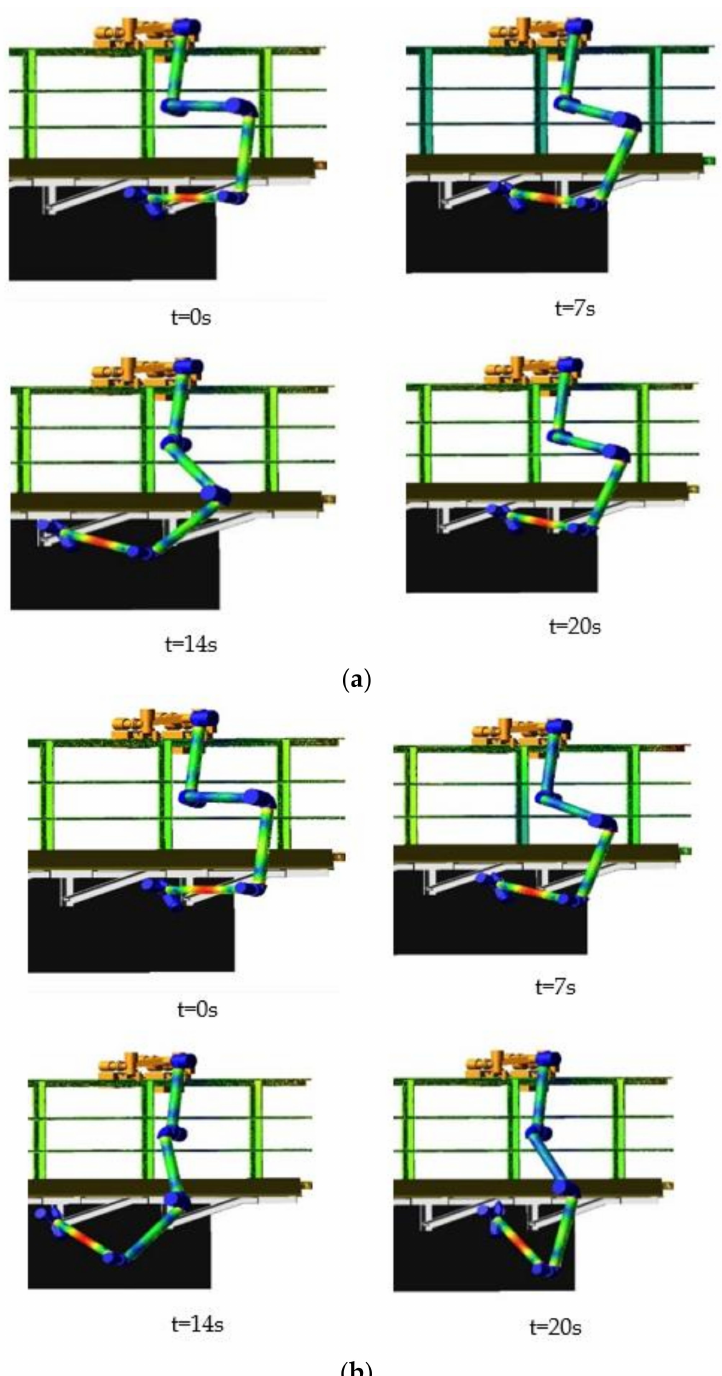
Figure 15. Screenshots of the simulation. ( a ) Without optimization, ( b ) With optimization. The tracking errors of the end effector in the simulation are shown in Figure 16. It can be clearly seen that the tracking errors of the trajectory with optimization are smaller than the tracking errors of the trajectory without optimization. The mean deviation and standard deviation of the tracking errors in linear working path simulation are shown in Table 4. It can be calculated from Table 4 that, the absolute value of the mean deviation of the tracking errors of the X-axis, Y-axis, and Z-axis decreased by 50.1%, 65.8%, and 62.3%, respectively, with vibration-reduction optimization. The results indicate that the proposed algorithm can markedly reduce the vibration in the triangle working